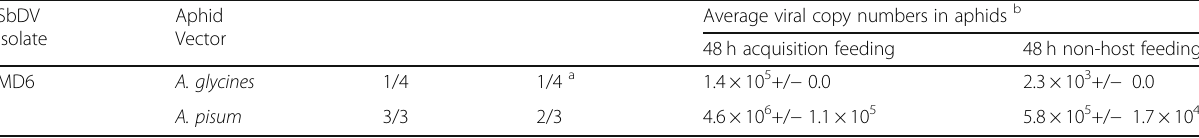
a Acquisition and retention values represented by two fractions. The first fraction represents the number of times the aphid acquired the virus from feeding on infected host tissue/total number of experimental repetitions. The second fraction represents the number of times the aphid retained the virus after feeding on non-infected non-host tissue/total number of experimental repetitions b Mean copy number values for all positive results with standard deviations determined by RT-qPCR. In cases where only a single sample tested positive, the standard deviation is listed as